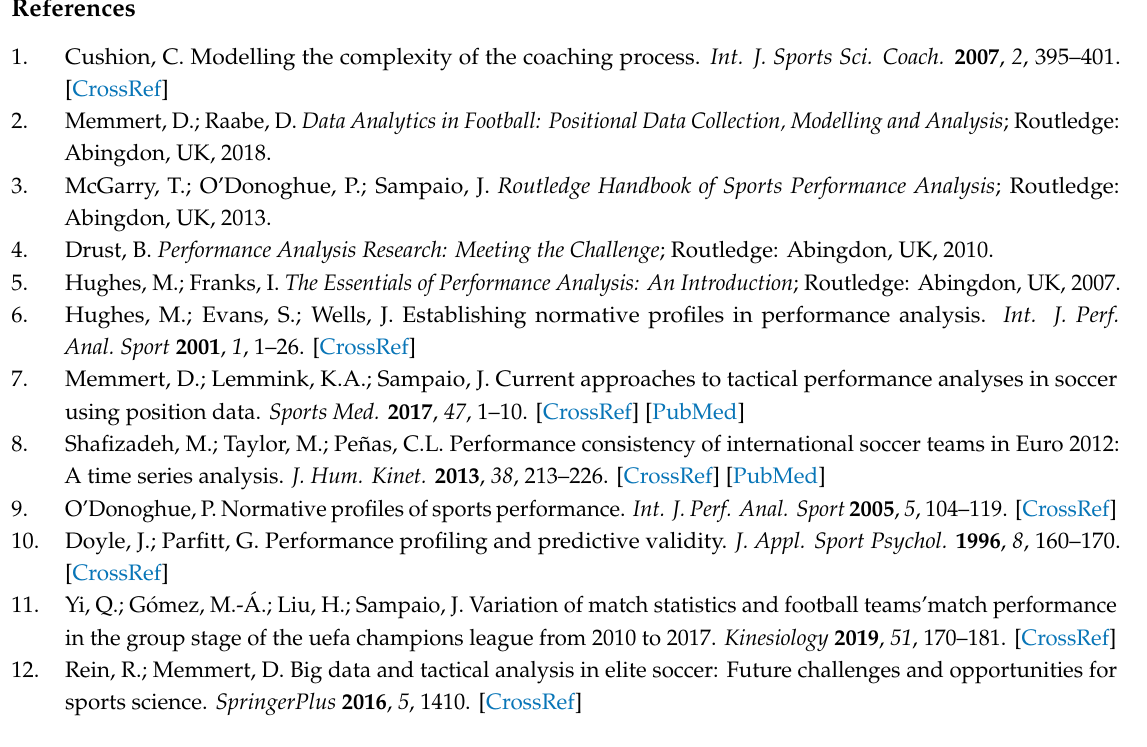
Table S1. Descriptive statistics of match performance profiles of central defenders under five competing situations. Table S2. Descriptive statistics of match performance profiles of full backs under five competing situations. Table S3. Descriptive statistics of match performance profiles of wide midfielders under five competing situations. Table S4. Descriptive statistics of match performance profiles of central midfielders under five competing situations. Table S5. Descriptive statistics of match performance profiles of forwards under five competing